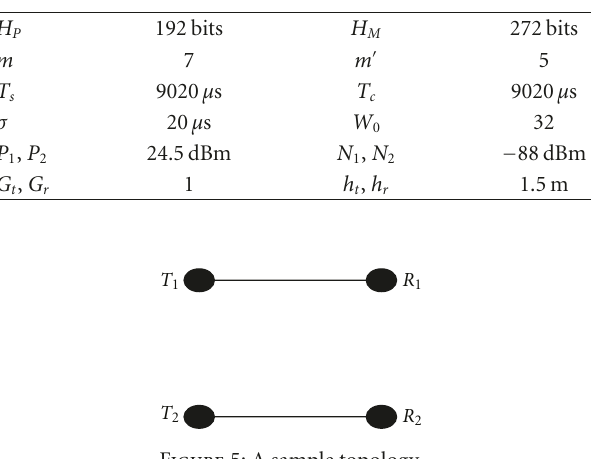
Table 2: Parameters used for the analytical results.